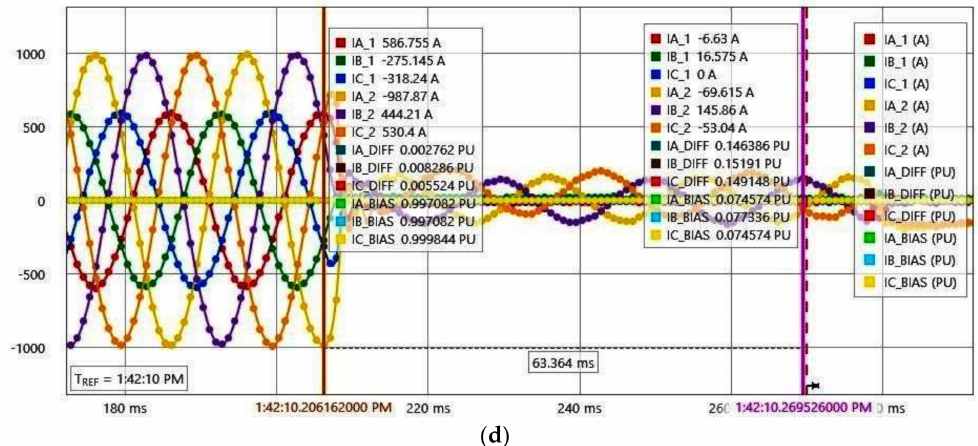
Figure 7. Pickup and drop-off test of differential relay: ( a ) HV side blue phase, ( b ) LV side yellow phase, ( c ) HV side three phase, ( d ) LV side three